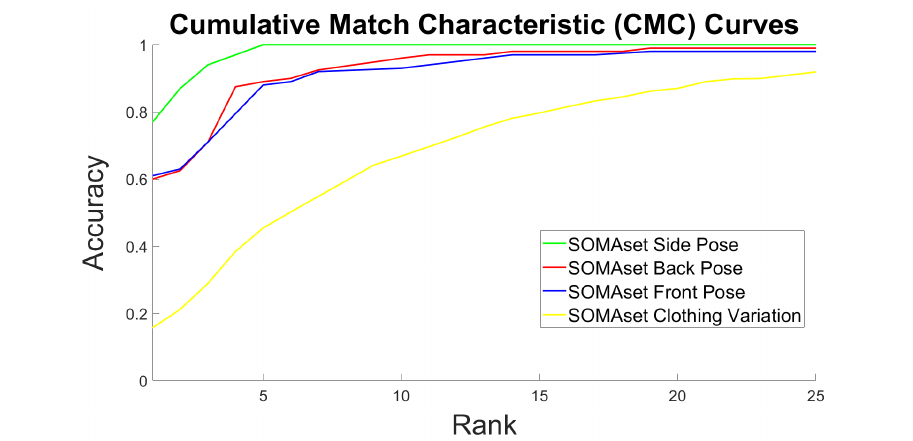
Figure 10. SOMAset dataset CMC curves for different poses and clothing variation as achieved by the Inception V3